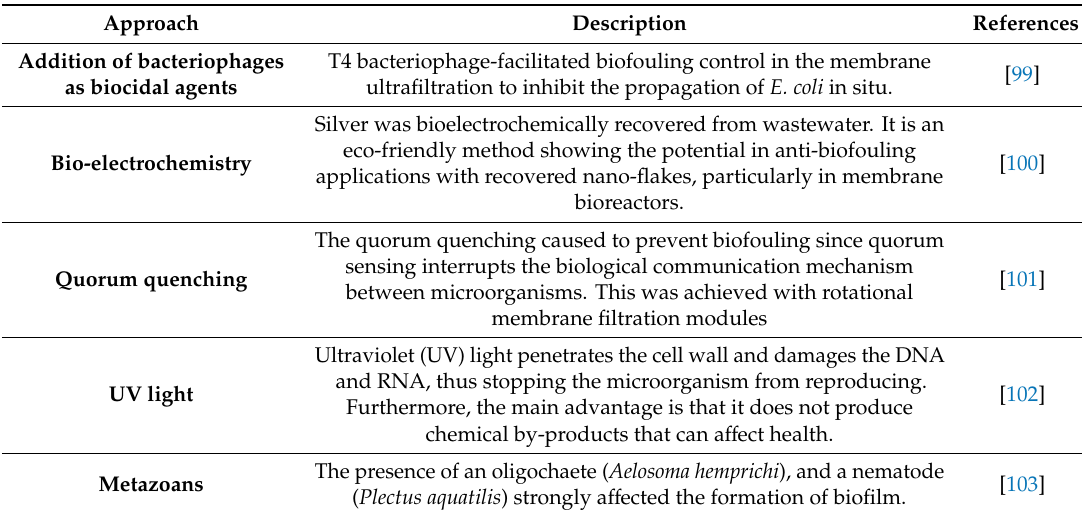
Table 6. Alternative novel approaches for biofouling mitigation.